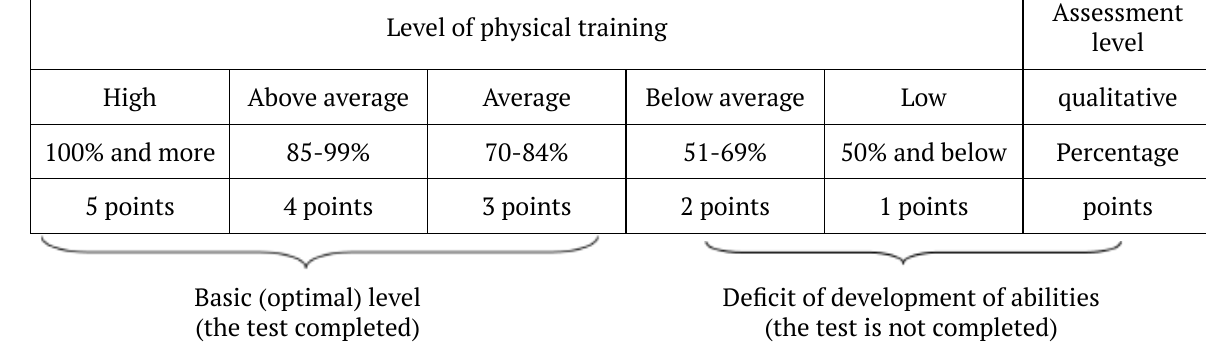
Figure 1. Structural diagram of the rating scale of physical Table 3. Indicators of physical fitness of students,